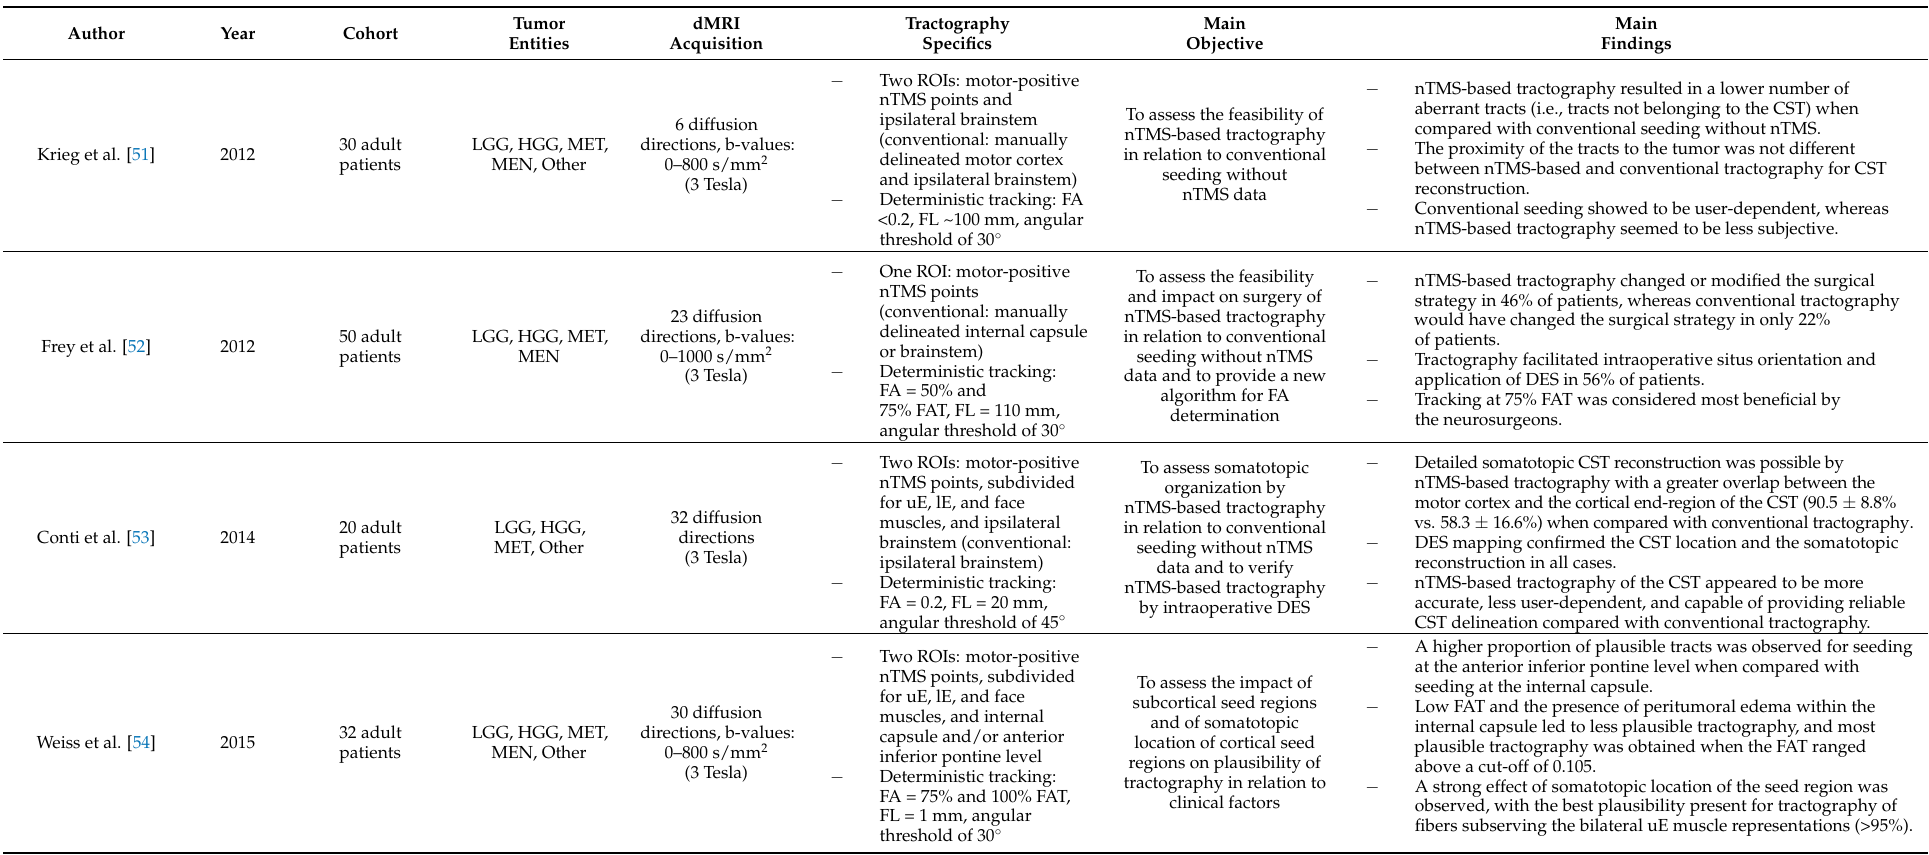
Table 2. Fiber tractography. This table presents the studies published on tractography of the CST primarily using motor mapping by nTMS (using an electric-field-navigated system) for seeding in patients harboring brain